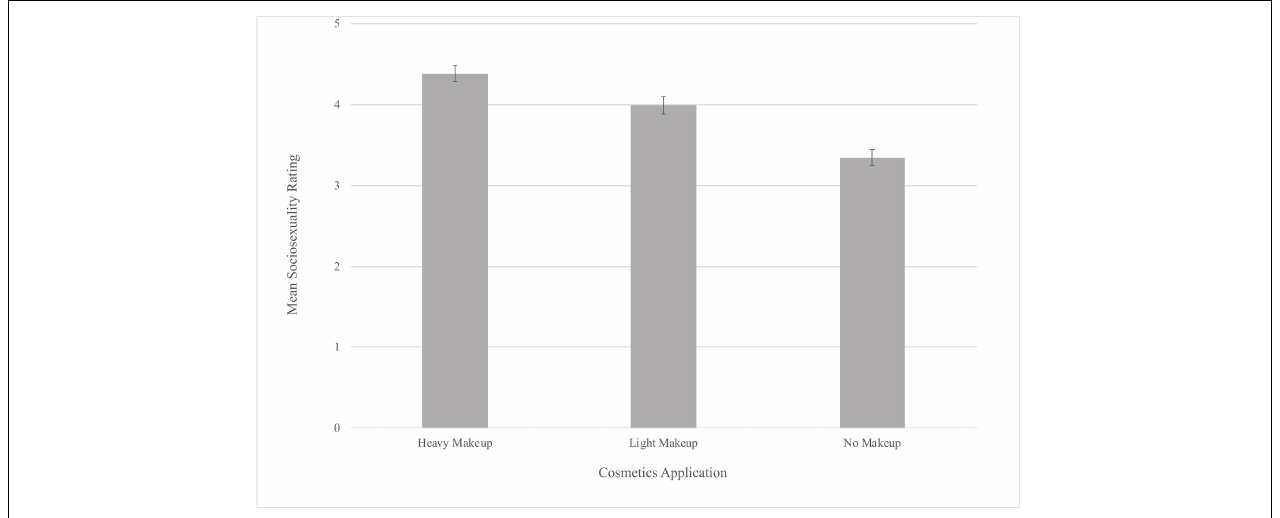
FIGURE 4 | Mean Sociosexuality Ratings by Makeup Application (error bars represent 95% confidence